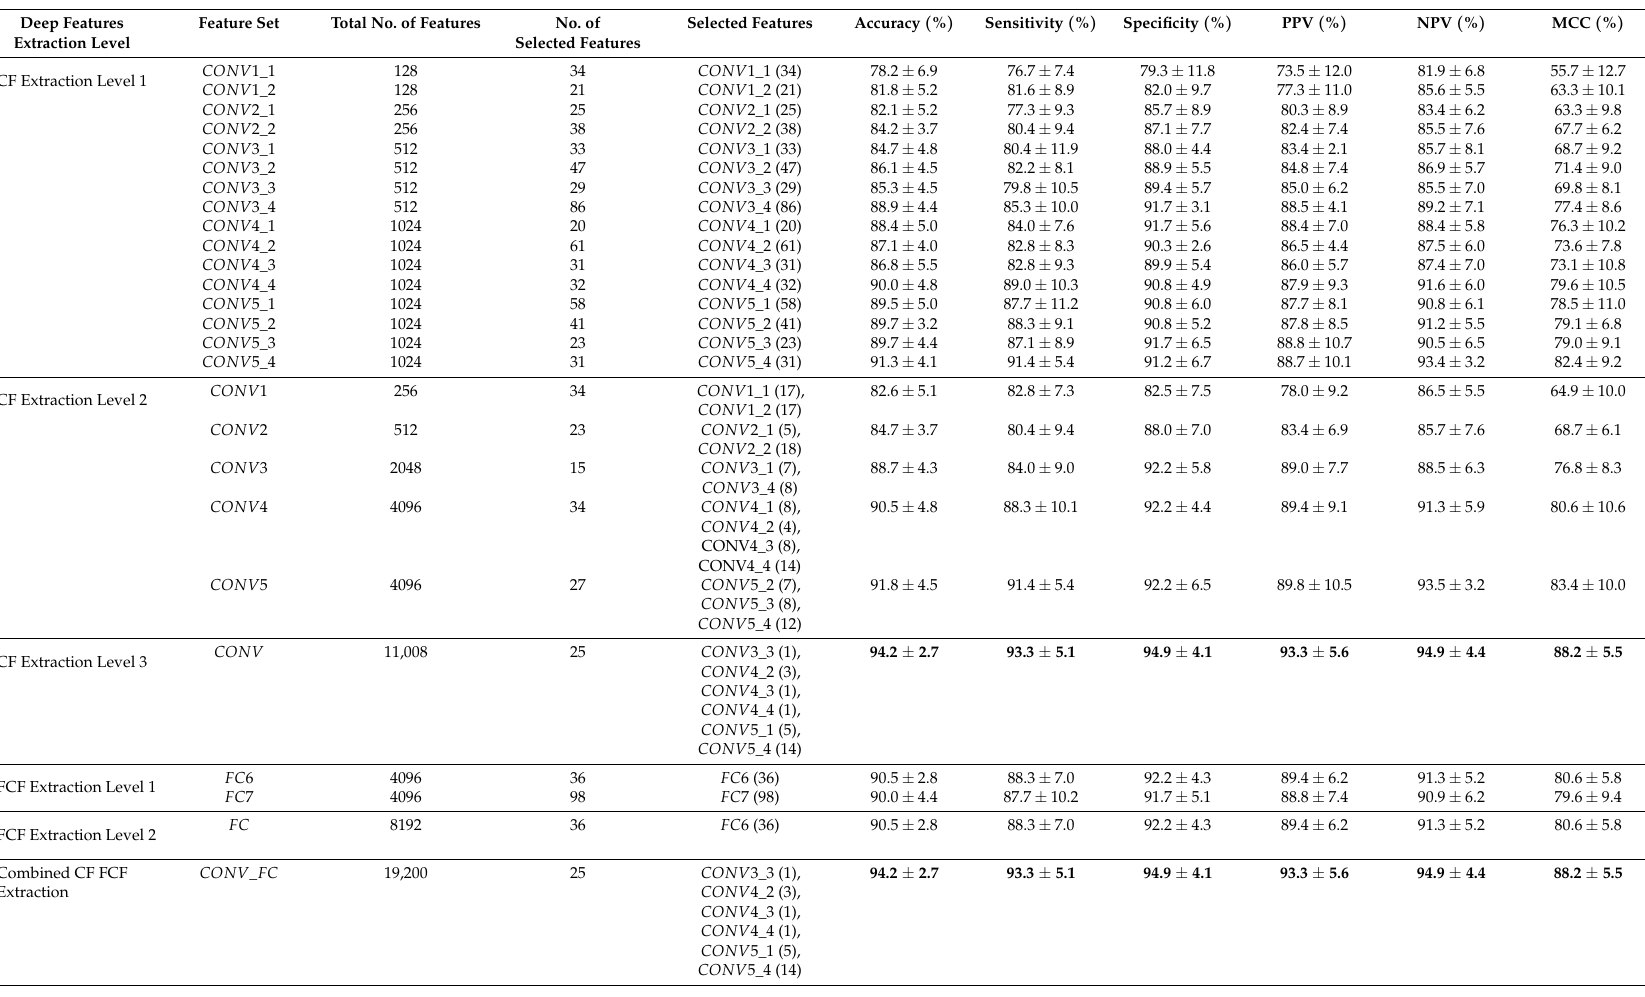
Table 3. The BUS image classification results obtained using the feature sets extracted from the pre-trained VGG19 model at six deep features extraction levels. For the six performance metrics, the mean ± standard deviation values are computed across the ten folds of the cross-validation procedure performed using Dataset